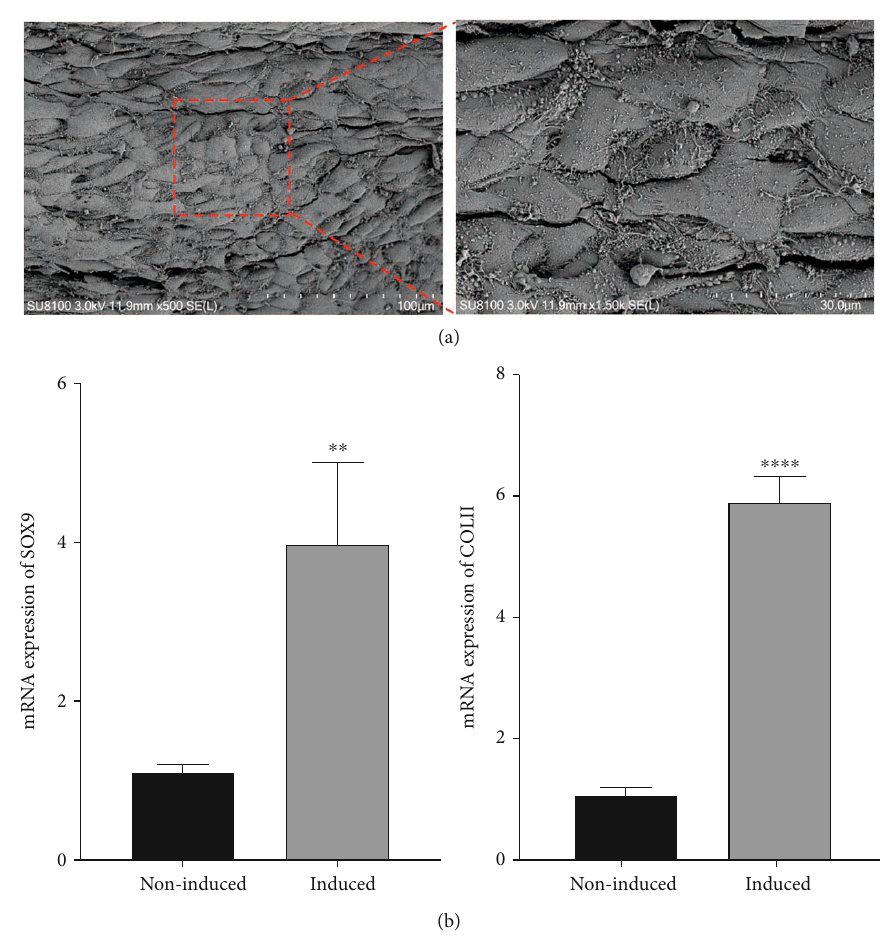
Figure 5: Chondrogenic induction of hAMSC sheet. (a) The SEM results of hAMSCs sheet induced by chondrogenic induction medium. (b) mRNA level of SOX9 and collagen type II. Compared with the noninduced group, mRNA expressions of SOX9 and collagen type II were signi fi cantly increased in the induced group on day 14 ( ∗∗∗∗ P < : 0001